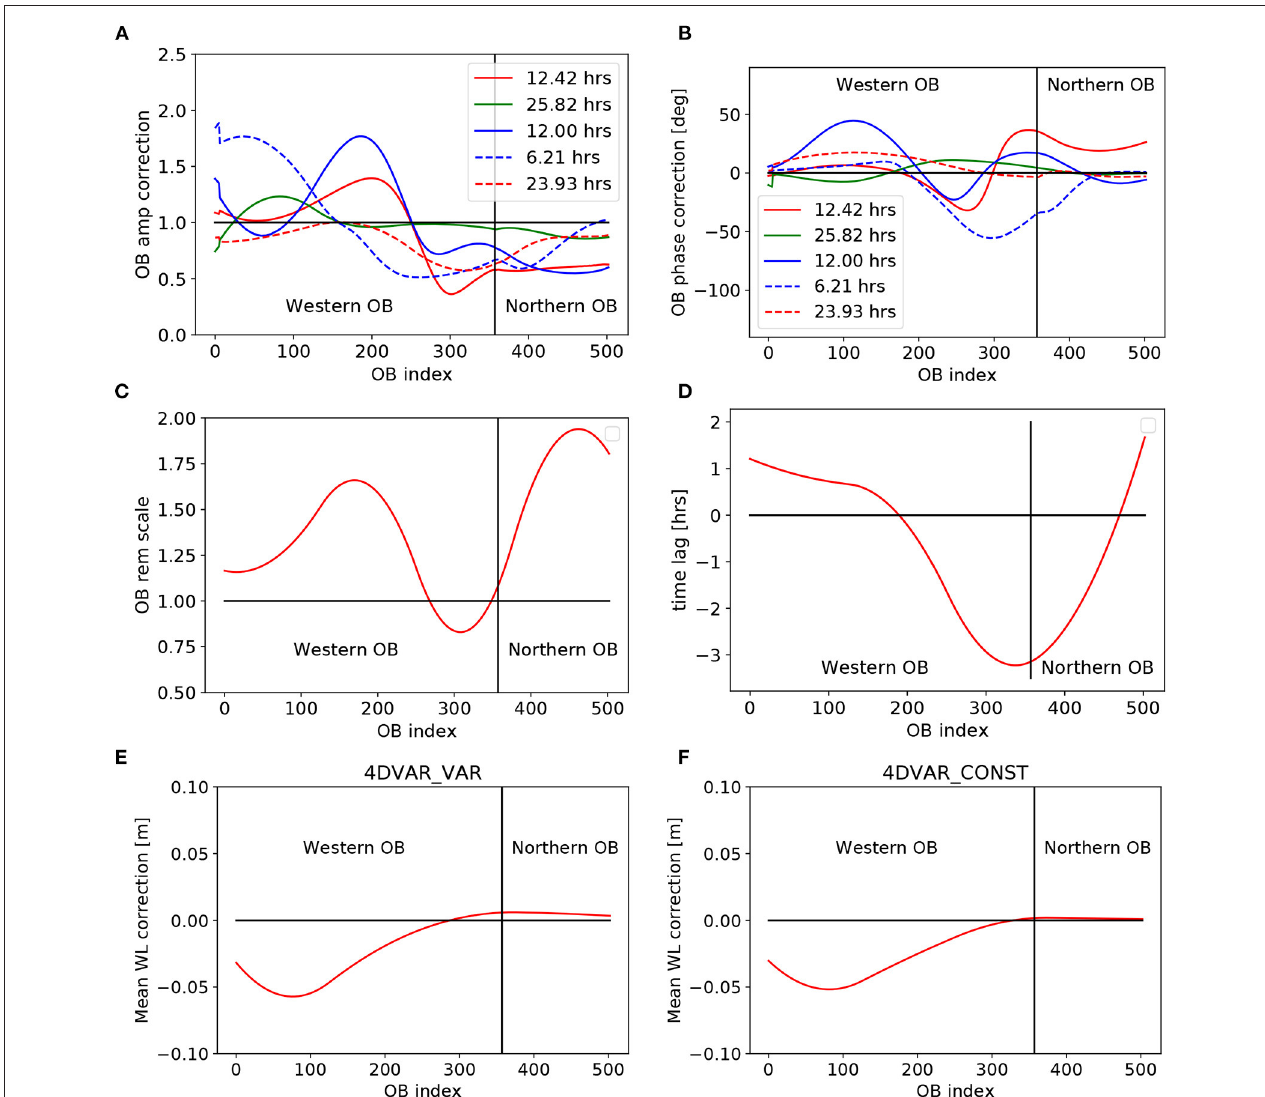
FIGURE 9 | Amplitude (A) and phase (B) corrections of 5 tidal components along the open boundary estimated by the 4DVAR scheme. (C,D) Scaling (C) and time shift (D) of the remaining signal along the open boundary. (E,F) Corrections of mean water elevation along the open boundary for experiment IMCO_VAR (E) and IMCO_CONS (F)